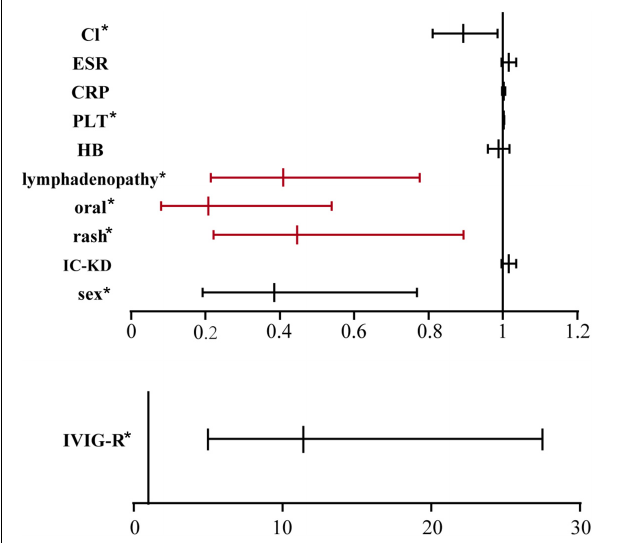
FIGURE 1 | Multivariable-adjusted forest plot for the risks of CAA. IVIG-R was separated from other indices because of the great difference in the abscissa scale. * p < 0.05.